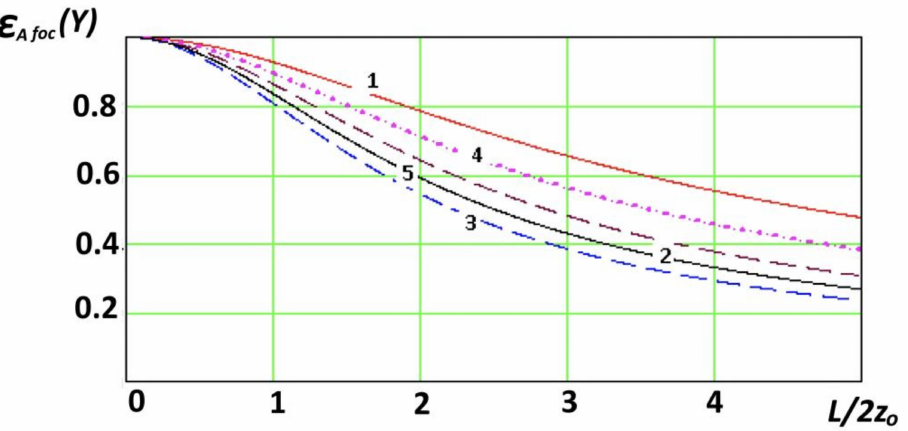
Figure 10. Dependence of ε A foc ( L , z 0 ) on L /2 z 0 values corresponding to optimal amplitude distri- butions in accordance with the data from Table